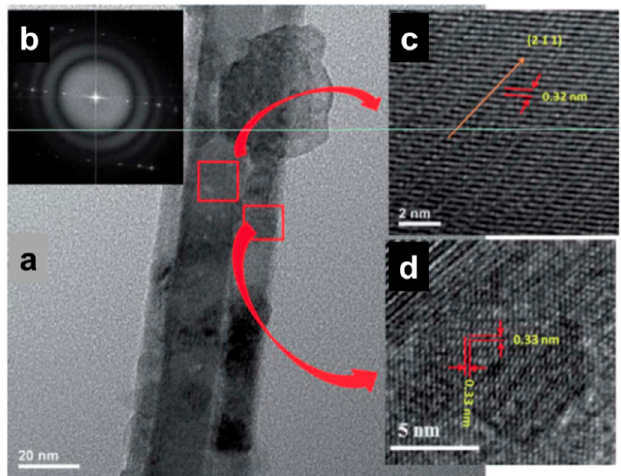
Figure 7. ( a ) HRTEM image; ( b ) SAED pattern of CdS decorated Bi 2 S 3 nanowires; magnified HRTEM images of ( c ) Bi 2 S 3 nanowire; ( d ) CdS nanoparticle [104].